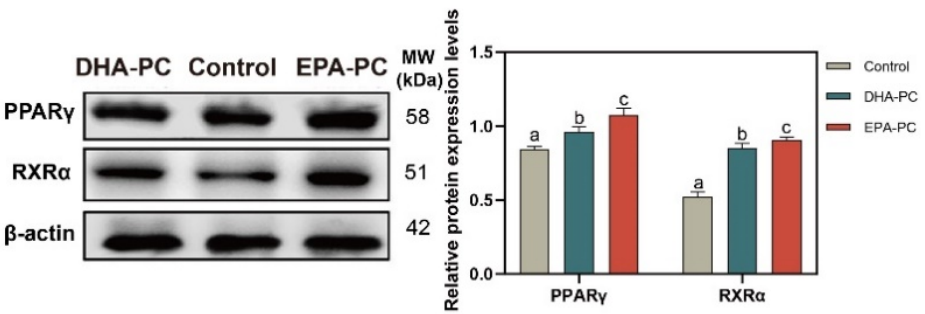
Figure 5. DHA-PC and EPA-PC increased the protein levels of PPAR γ and RXR α . The expression of PPAR γ and RXR α . Different letters (a, b, and c) indicate remarkable differences at p < 0.05 among all groups determined by ANOVA (Bonferroni’s test).